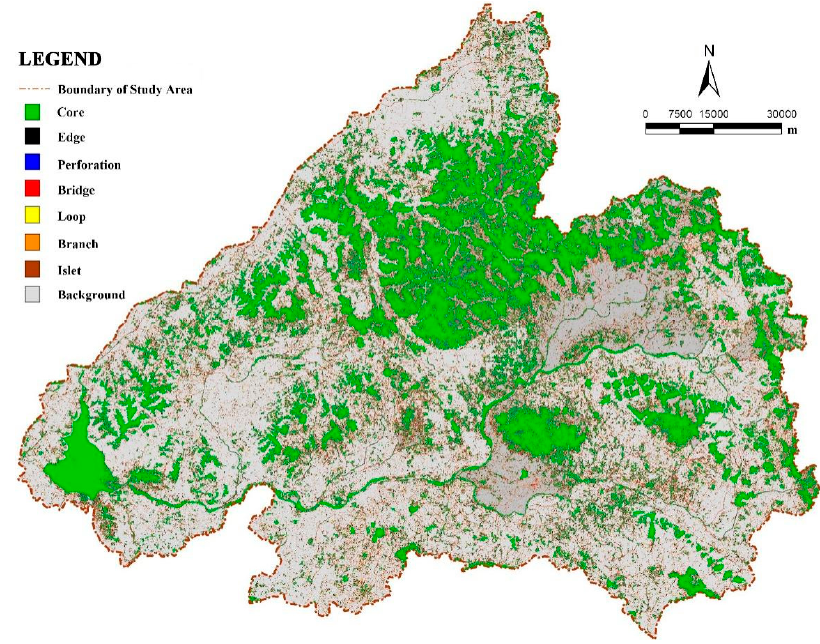
Figure 4. MSPA landscape types in Taishan area.